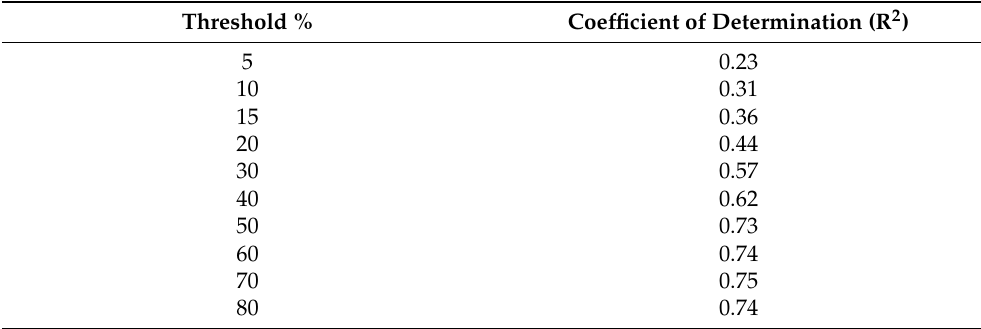
Table 1. Coefficient of determination (R 2 ) of different thresholding percentages of severe kernel pixels over total kernel pixels to classify a kernel as severe and the GC-MS DON content.